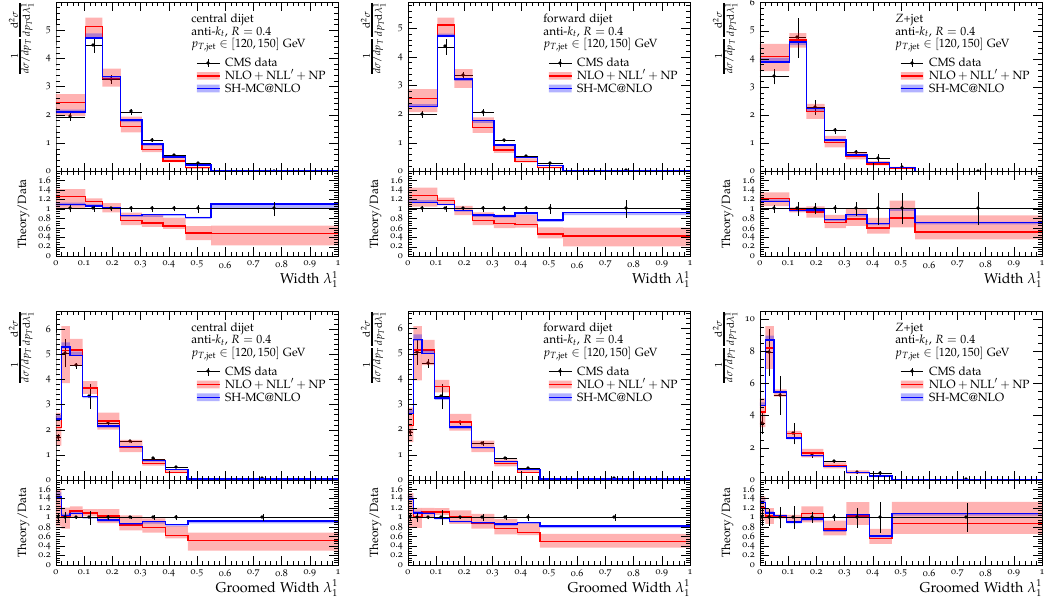
Figure 13. Results for the jet width λ 1 for ungroomed (top row) and groomed (bottom row) 1 R = 0 . 4 anti- k t jets with p T, jet ∈ [120 , 150] GeV. The left and middle panel correspond to the central and forward jet in dijet events, respectively, the right one to the leading jet in Z +jet production.